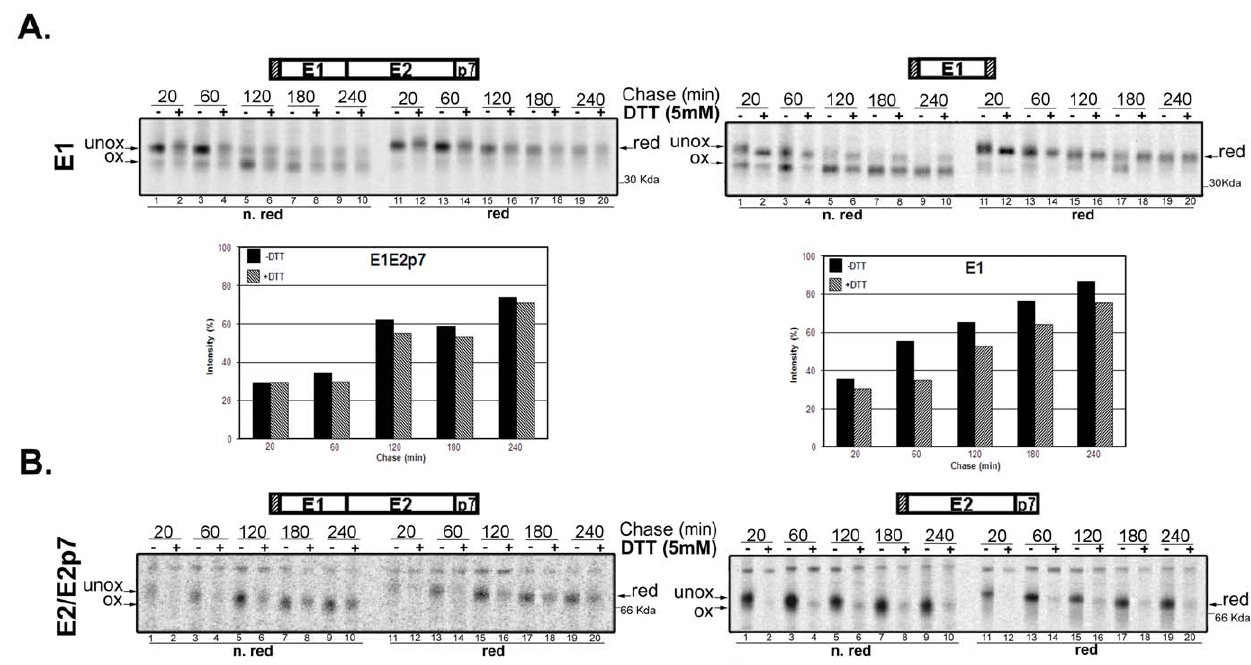
Figure 3. Analysis of DTT-resistance of HCV proteins E1 and E2. (A) CHO cells stably transfected with E1E2p7 or E1 were pulse-labeled with [ 35 S]-methionine and –cysteine for 20 min and chased for different time-periods in the presence ( + ) or absence ( 2 ) of 5 mM DTT added exogenously 5 min before the indicated chase-time. PNSs were immunoprecipitated with the CBH-111 anti-E1 antibody and samples analyzed on 10% SDS-PAGE in non-reducing (lanes 1–10) and reducing (lanes 11–20) conditions. Graphs below represent the percentage of oxidized E1 present in samples derived from untreated (black bars) and DTT-treated (dashed bars) cells. The relative intensity-percentage is calculated by densitometric analysis of the unoxidized and oxidized forms in non-reducing conditions in the presence (lanes 1, 3, 5, 7, 9) or absence (lanes 2, 4, 6, 8) of 5 mM DTT added exogenously 5 min before the indicated chase-period. Left graph reports values obtained when expressed with E2p7, right graph when expressed individually. (B) CHO cells stably transfected with E1E2p7 or E2p7 were pulse-labeled with [ 35 S]-methionine and –cysteine for 20 min and chased for different time-periods in the presence ( + ) or absence ( 2 ) of 5 mM DTT added exogenously 5 min before the indicated chase-time. PNSs were immunoprecipitated with CBH-7 anti-E2 antibody and samples analyzed on 10% SDS-PAGE in non-reducing (lanes 1–5) and reducing (lanes 6–10) conditions. Symbols refer to: ox for oxidized; unox for unoxidized; red for reduced.